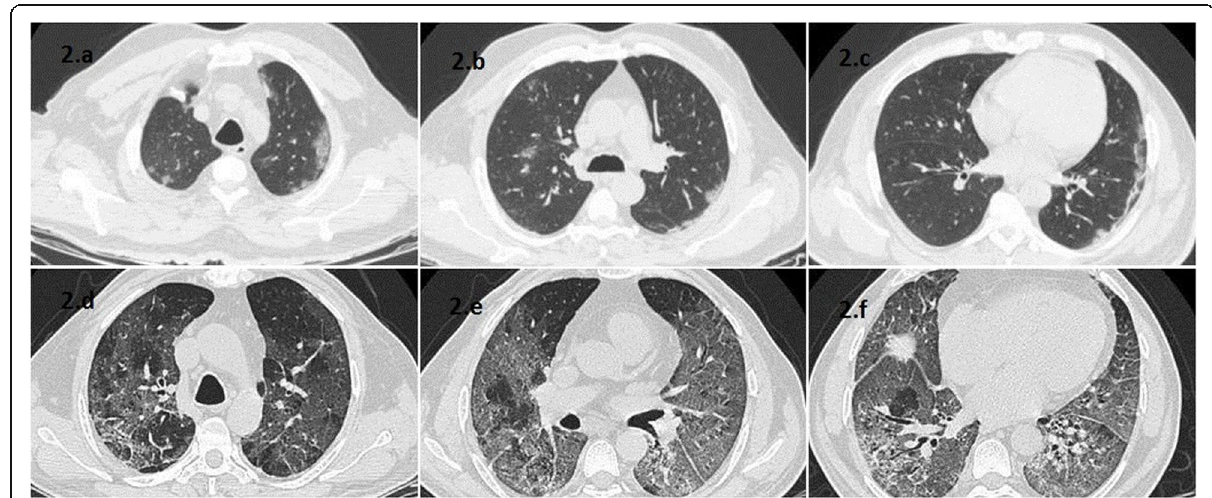
Fig 2 a - c 50-year-old male with clinically mild COVID pneumonia and CTSS of 11, d - f 45-year-old male with clinically severe COVID pneumonia and CTSS of